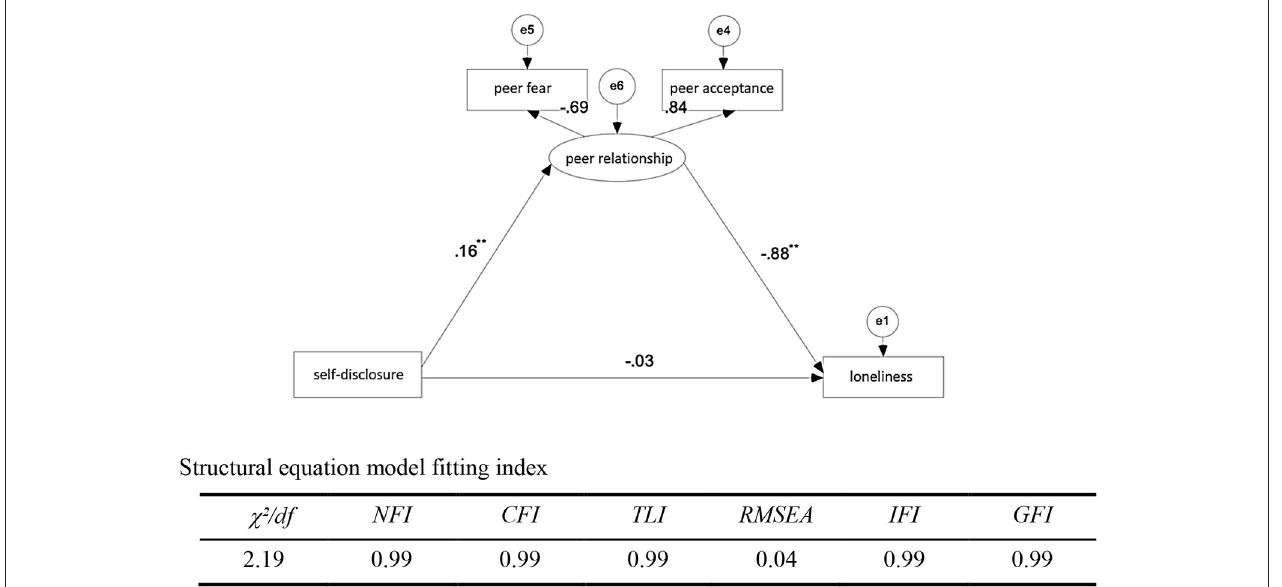
FIGURE 1 | Mediating effect model of peer relationship between self-disclosure and